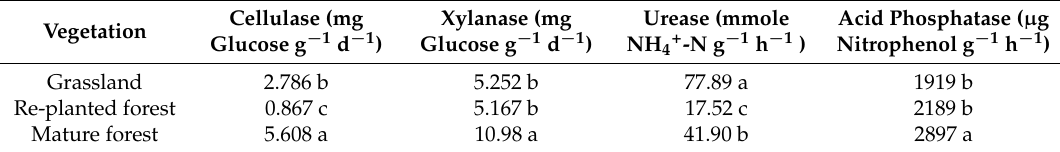
Table 2. Soil enzymatic activities in the three types of